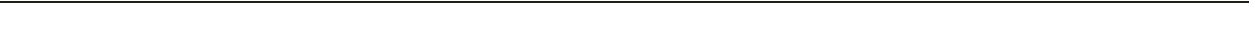
Fig. 6 BMI1 inhibition delays CRPC progression in vivo. a , b Representation of combination index plot of enzalutamide combined with PTC209 in a AR- positive cells and b AR-negative cells. Doses below the dotted line represent the synergistic effect and doses above the dotted line represent the antagonistic effect. c Castration-resistant VCaP xenograft mouse models were generated as described in “ Methods ” section. Castrated mice carrying